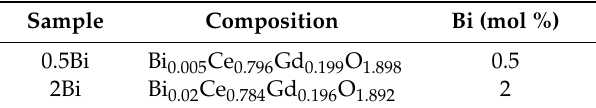
Table 1. Synthesized samples, composition, and Bi content.